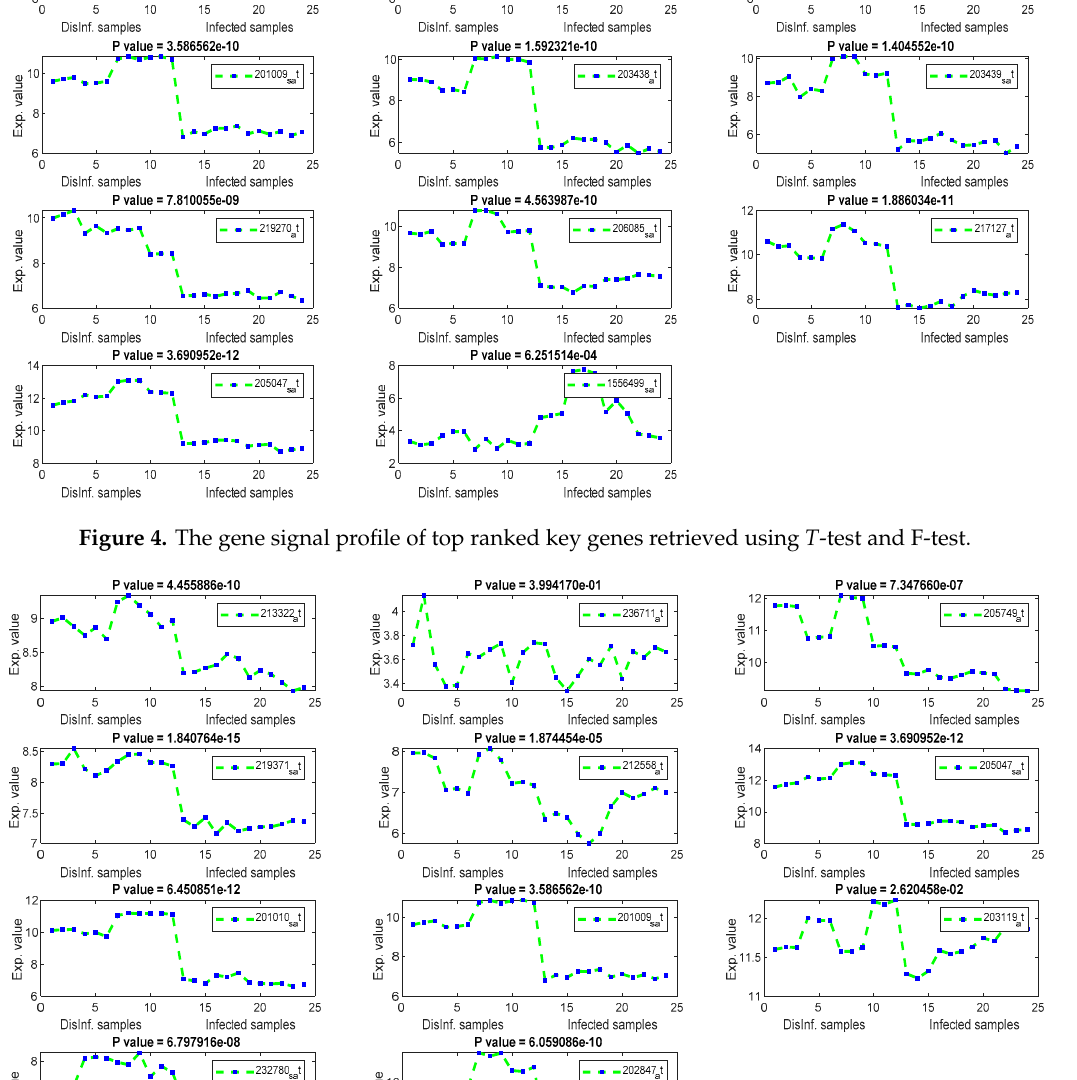
Figure 6. The gene signal profiles of top ranked key genes retrieved using Euclidean distance.